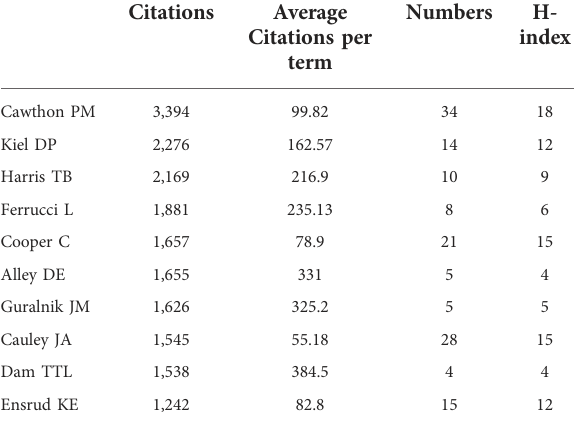
TABLE 1 The general information of the top 10 authors with the most